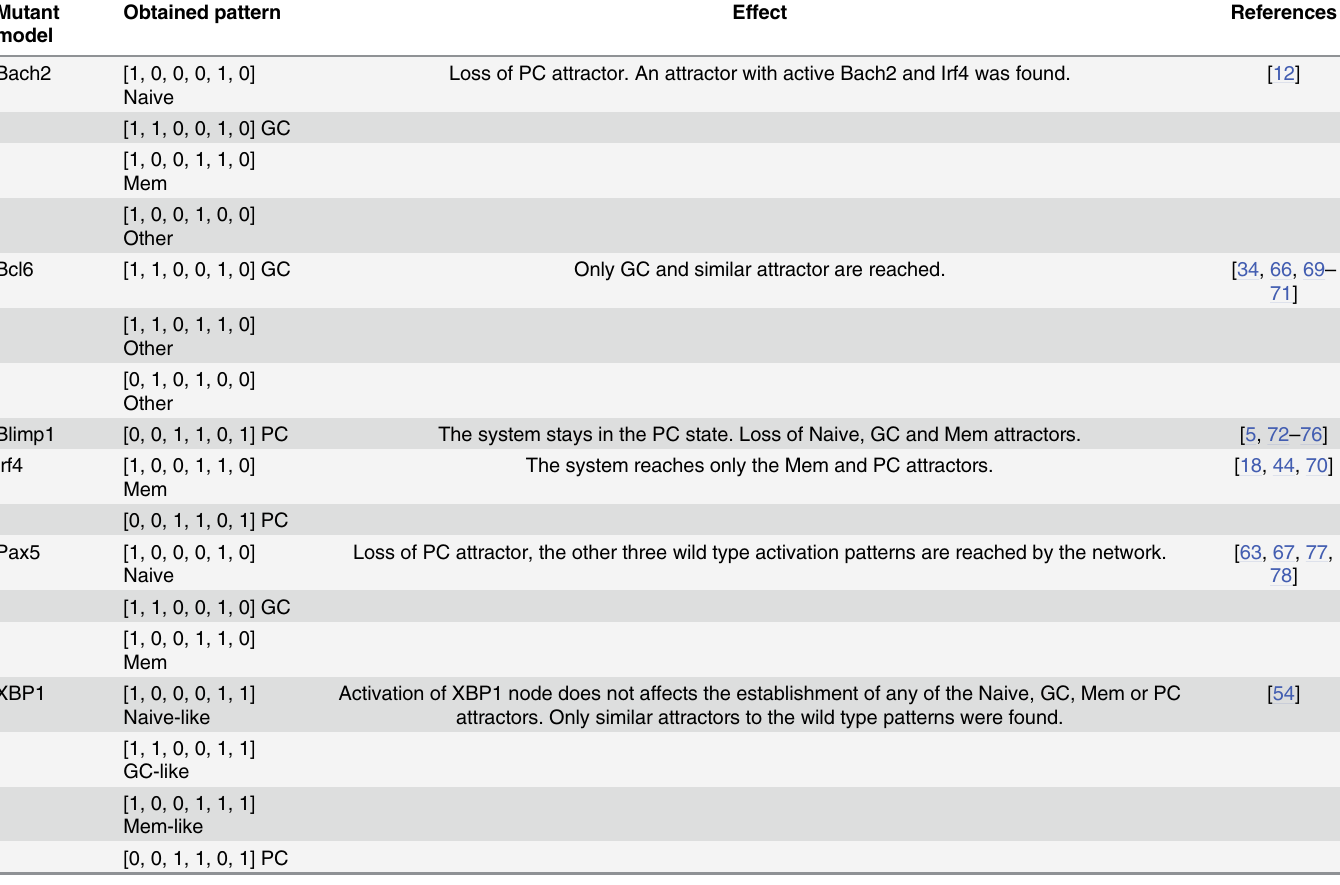
Constitutive mutant attractors. The attractors found for each mutant model and the literature supporting its effect are summarized, for simplicity, only the patterns of activation for the nodes that conform the core of the network, namely Bach2, Bcl6, Blimp1, Irf4, Pax5 and XBP1 are shown. The steady state pattern for each mutant is shown in the following order: [Bach2, Bcl6, Blimp1, Irf4, Pax5,